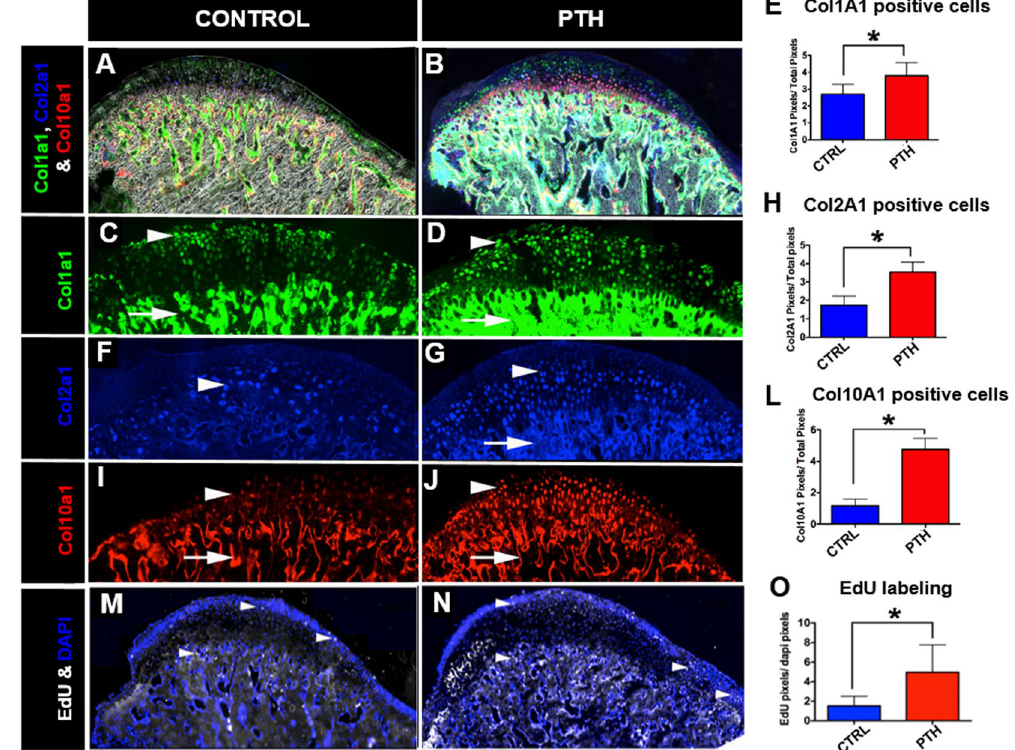
Figure 3. I-PTH leads to increased Col1a1, Col2a1 and Col10a1 expressing cells. Sagittal sections of the MCC and subchondral bone of triple transgenic mice (Col1a1 X Col2a1 X Col10a1) in the control ( A ) and I-PTH ( B ) groups. Col1a1 cells in the MCC (arrowhead) and subchondral bone (arrow) in the control ( C ) and I-PTH ( D ) groups. Col2a1 cells in the prehypertrophic zone (arrowhead) of the MCC in control ( F ) and I-PTH ( G ) groups. Presence of Col2a1 cells in subchondral bone of experimental mice (arrow). Col10a1 cells in the hypertrophic zone (arrowhead) of the MCC in control ( I ) and I-PTH ( J ) groups. The red color (arrow) in the subchondral bone is alizarin complexone bone label (I–J). Histograms showing the significant increase in Col1a1 (p < 0.0004) ( E ), Col2a1 (p < 0.000) (H) and Col10a1 (p < 0.000) ( L ) positive pixels in the I-PTH group relative to controls. Sagittal sections stained for EdU in the control ( M ) and I-PTH ( N ) groups. EdU positive cells in the MCC (arrowhead) and subchondral bone (arrow). ( O ) Histogram showing the significant increase (p < 0.000) in EdU positive pixels (n = 5; 3 histological sections from each mice; CI for control group: 0.81–2.22; CI for I-PTH group: 2.96–6.96) in the experimental group (I-PTH). * Statistically s ignificant difference between control and I-PTH